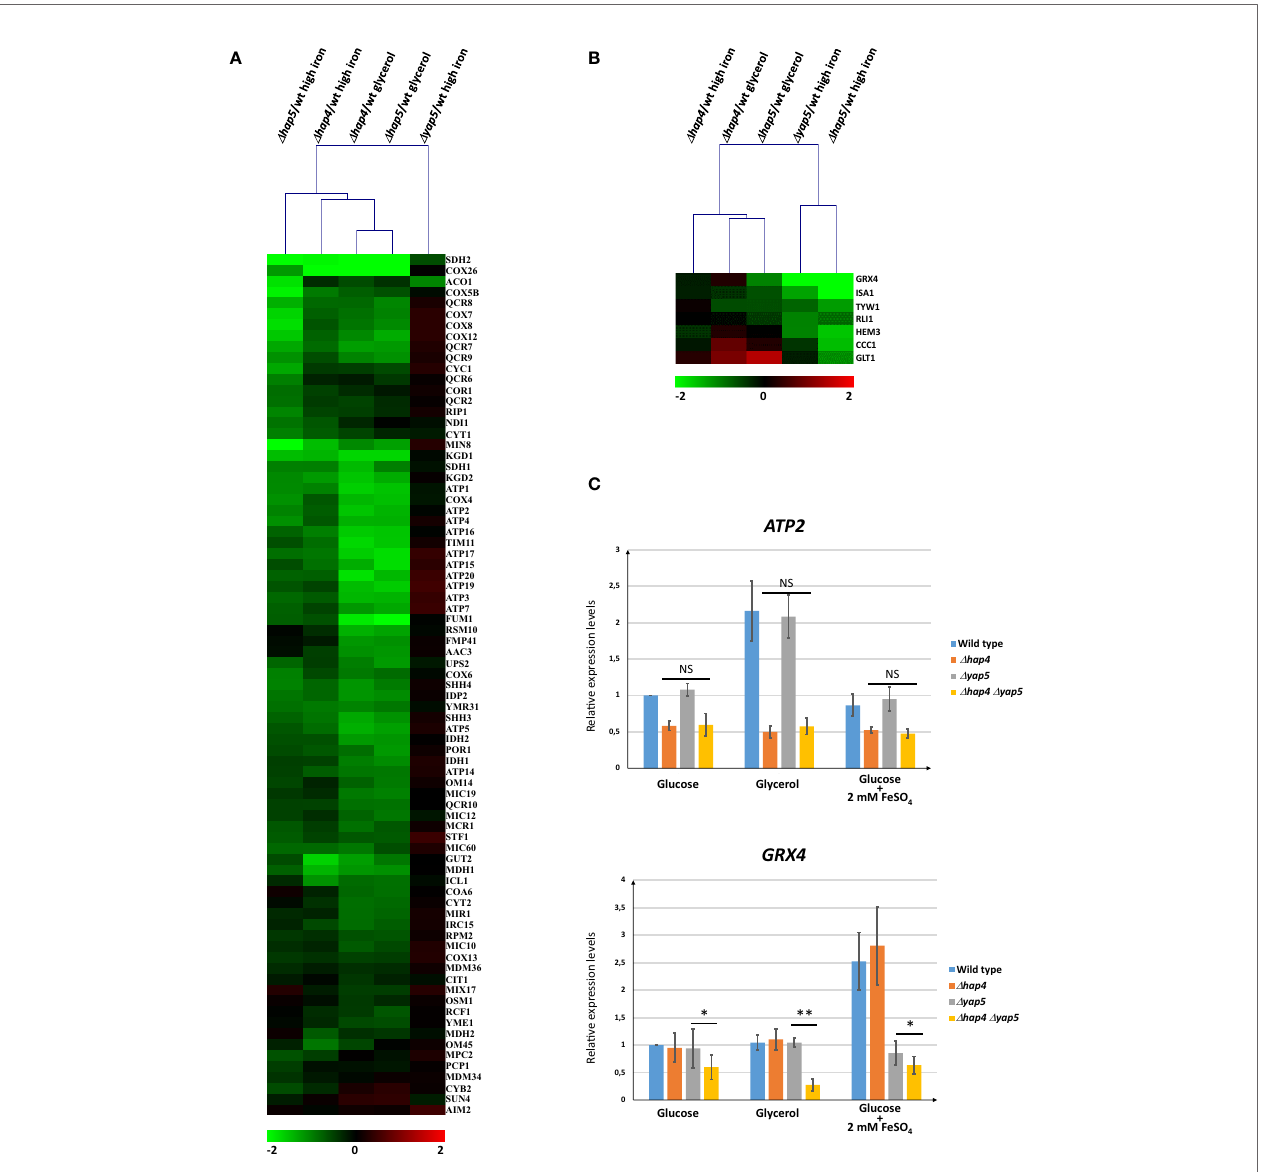
FIGURE 5 | Expression analyses of Hap4 gene targets in different growth conditions and genetic contexts. (A, B) Transcriptome comparisons of Hap4, Hap5 and Yap5 impact on gene expression. The D hap4 , D hap5 and D yap5 strains were grown in different conditions (glycerol media or glucose media with iron excess (2 mM FeSO 4 ) and their transcriptomes were compared to wild type cells grown in the same conditions using microarrays. The values represented on the eisengrams are log2 of mutant/wild type expression ratios. The color scale is indicated at the bottom of each eisengram. Hierarchical clustering using correlation distance was used to cluster the samples based on the expression pro fi les of either (A) the respiratory genes (as de fi ned in ) or (B) the iron tolerance genes (as de fi ned in ). The Yap5 and Hap5 high iron data are from Thie ́ baut et al., 2017. (C) Analyses of the impact of a double deletion of HAP4 and YAP5 on the expression of ATP2 (upper histogram) and GRX4 (lower histogram). The relative expression of ATP2 and GRX4 was measured by RT-qPCR in wild type, D hap4 , D yap5 and D hap4 D yap5 strains grown in glucose, glycerol or glucose + iron excess (2 mM FeSO 4 ). The values represent the expression levels of the ATP2 or GRX4 genes relative to ACT1 (used as an internal control) and to the wild type grown in glucose, which was arbitrarily set to 1. The experiments were performed six times on biologically independent samples, except for glycerol which was based on three replicates only. Error bars represent the pearson standard deviation. The results of a t-test comparing the expression levels of ATP2 between the D hap4 and the D yap5 D hap4 strains (upper panel) or the expression levels of GRX4 between the D yap5 and the D yap5 D hap4 strains (lower panel) are symbolized as follows: *p < 0.1, **p < 0.05, NS: p >